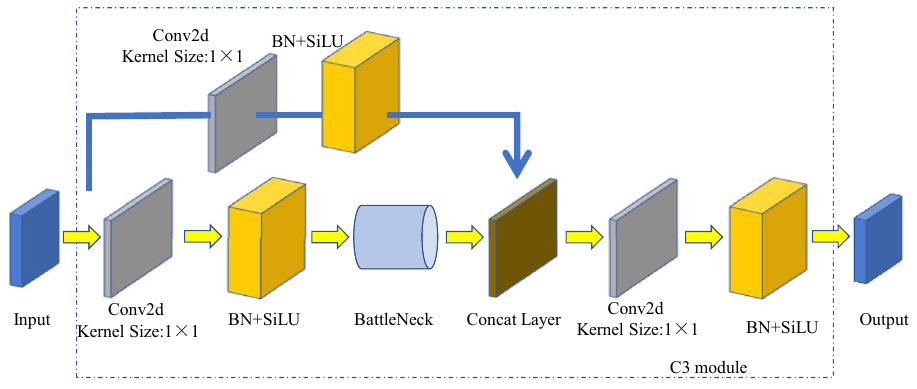
Figure 6. Structure of C3 module.